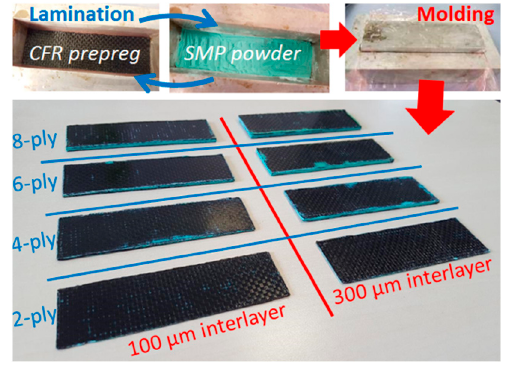
Figure 1. Samples for the durability